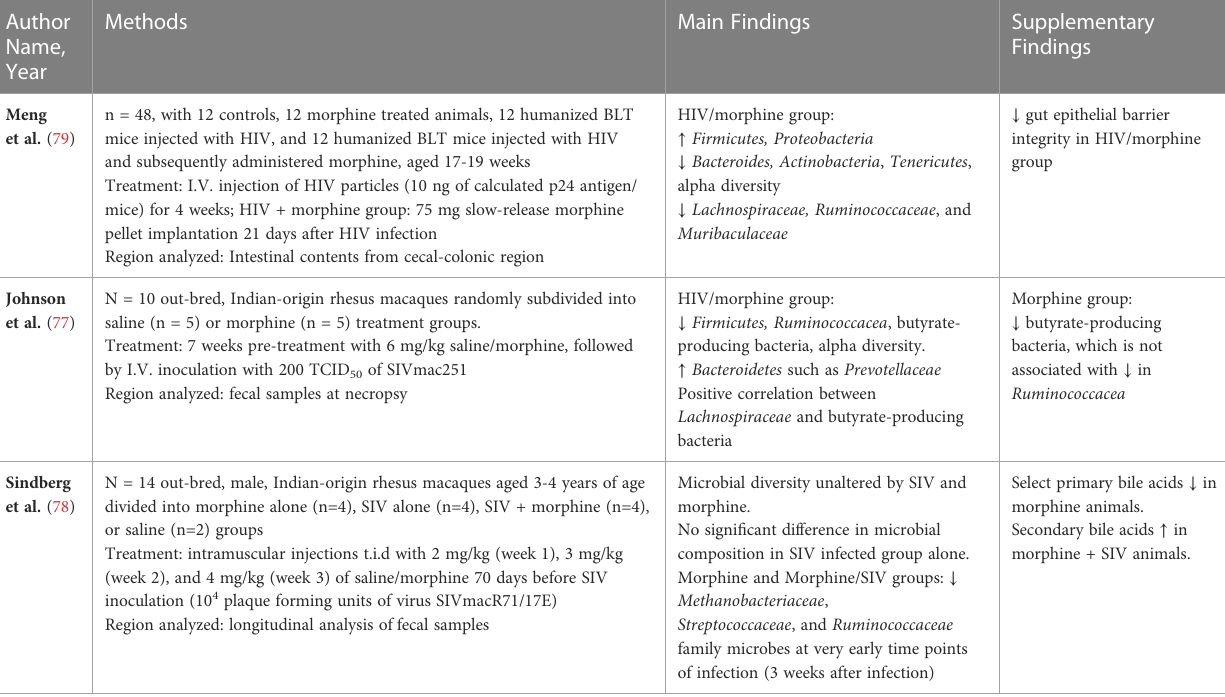
TABLE 1 Summary of preclinical studies detailing HIV and opioid-induced microbial